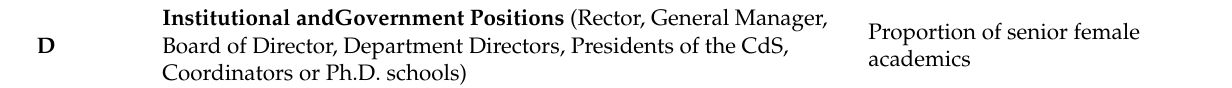
Table 1. Cont. CRUI Guideline THE